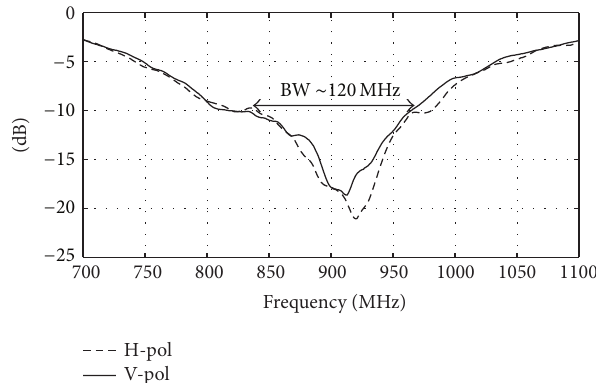
Figure 11: Return loss of SAR-High antenna: comparison between H and V polarizations.